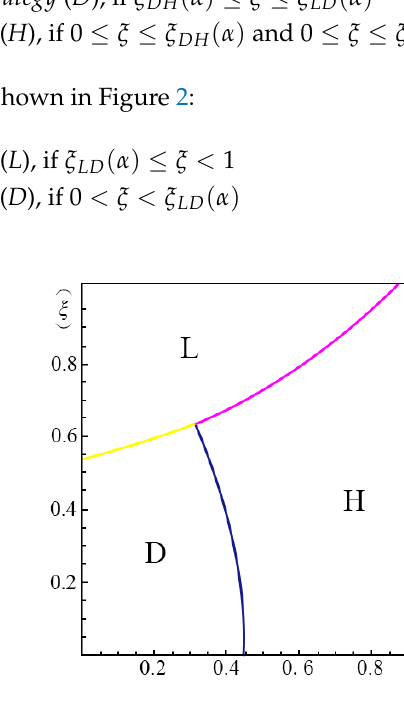
Figure 1. Comparison of the four strategies given δ = 1